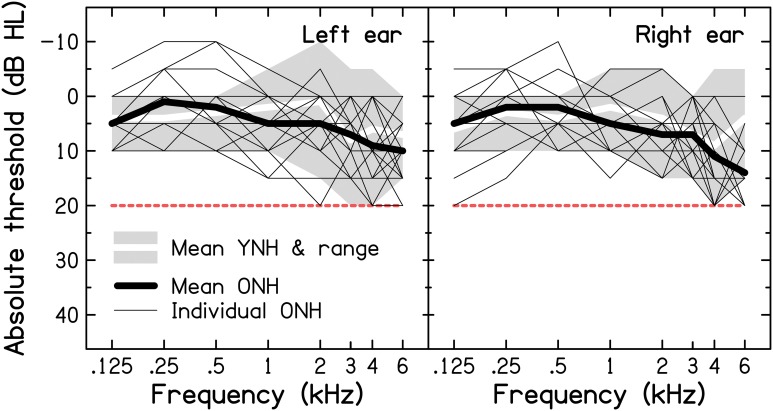
Results of pure-tone air-conduction audiometry for the left (left panel) and right ears (right panel) of the nine YNH and 21 ONH participants. The thin and thick black lines represent the individual and mean audiograms of the ONH participants. The thick white lines and associated light-gray shaded areas represent the mean audiograms and ranges of audiometric thresholds for the YNH participants, respectively. The dashed red line indicates the audiometric inclusion criteria used in the present study.